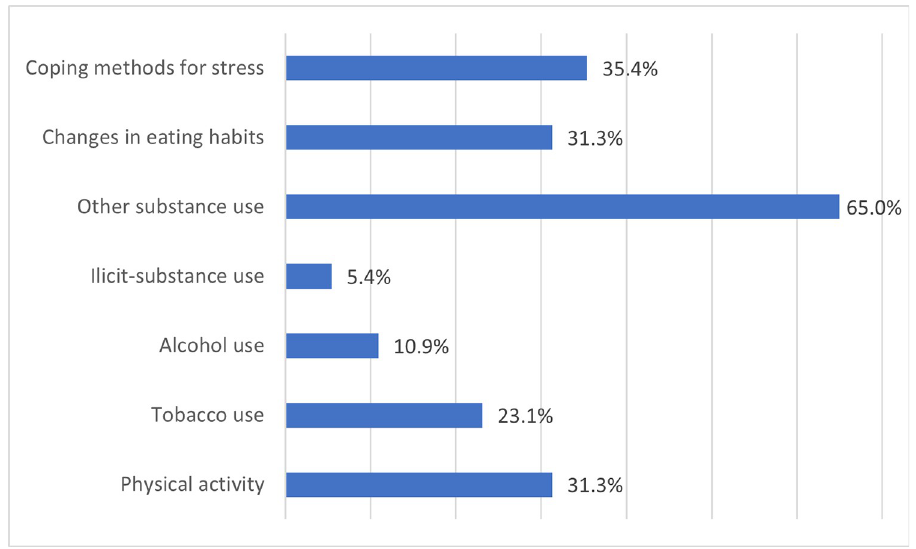
Fig 1. Descriptive values of lifestyle factors of the study sample, n =